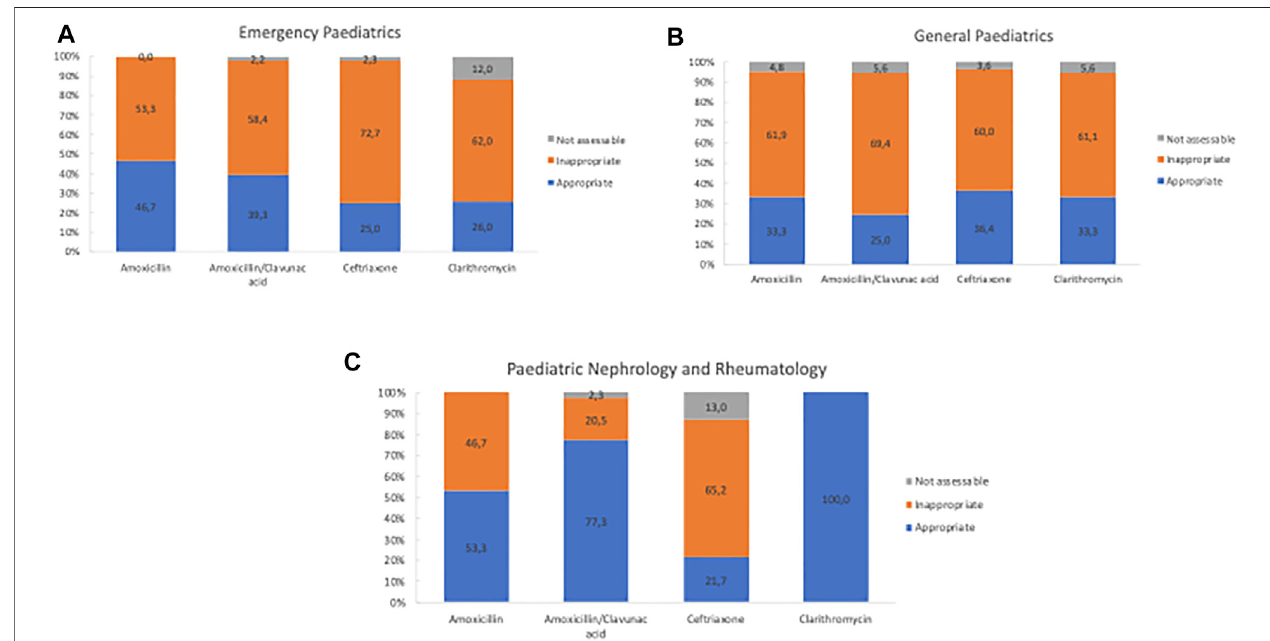
FIGURE 3 | Distribution of appropriateness of the main antibiotic prescriptions strati fi ed by subspecialties.